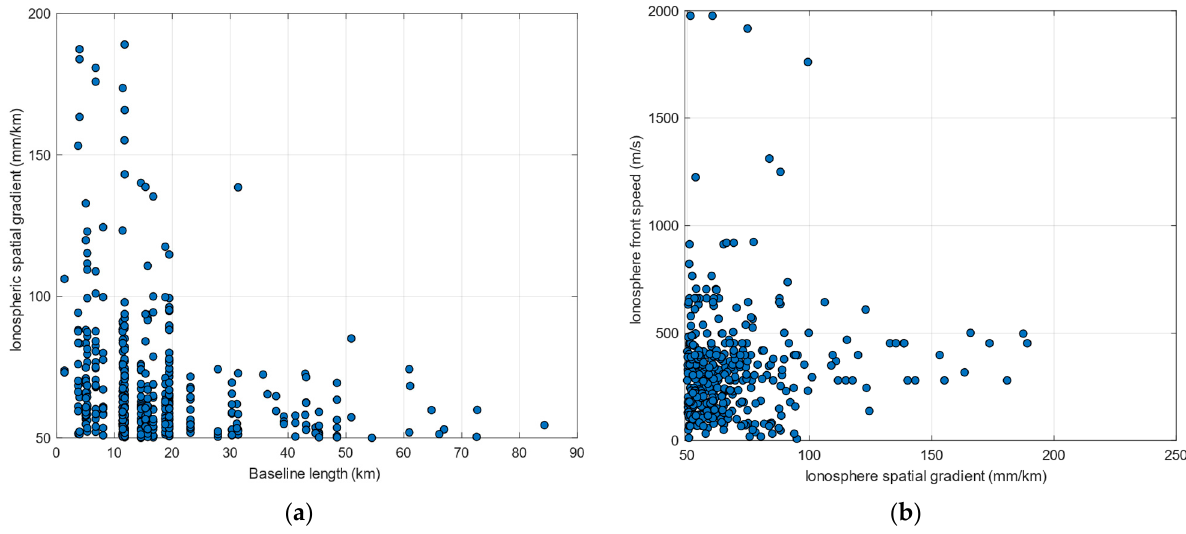
Figure 3. ( a ) Scatterplot of the ionospheric front slope and the baseline between monitoring stations; ( b ) Scatterplot of the ionospheric front speed and magnitude of the slope. ( b ) Scatterplot of the ionospheric front speed and magnitude of the